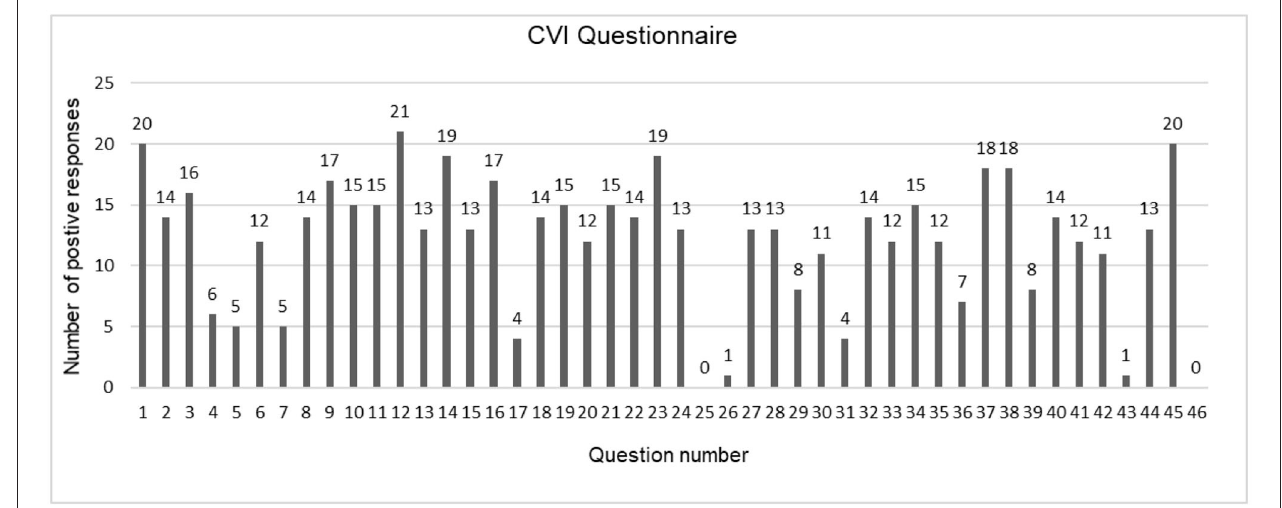
FIGURE 2 | Visual needs among children with cerebral visual impairment (10).